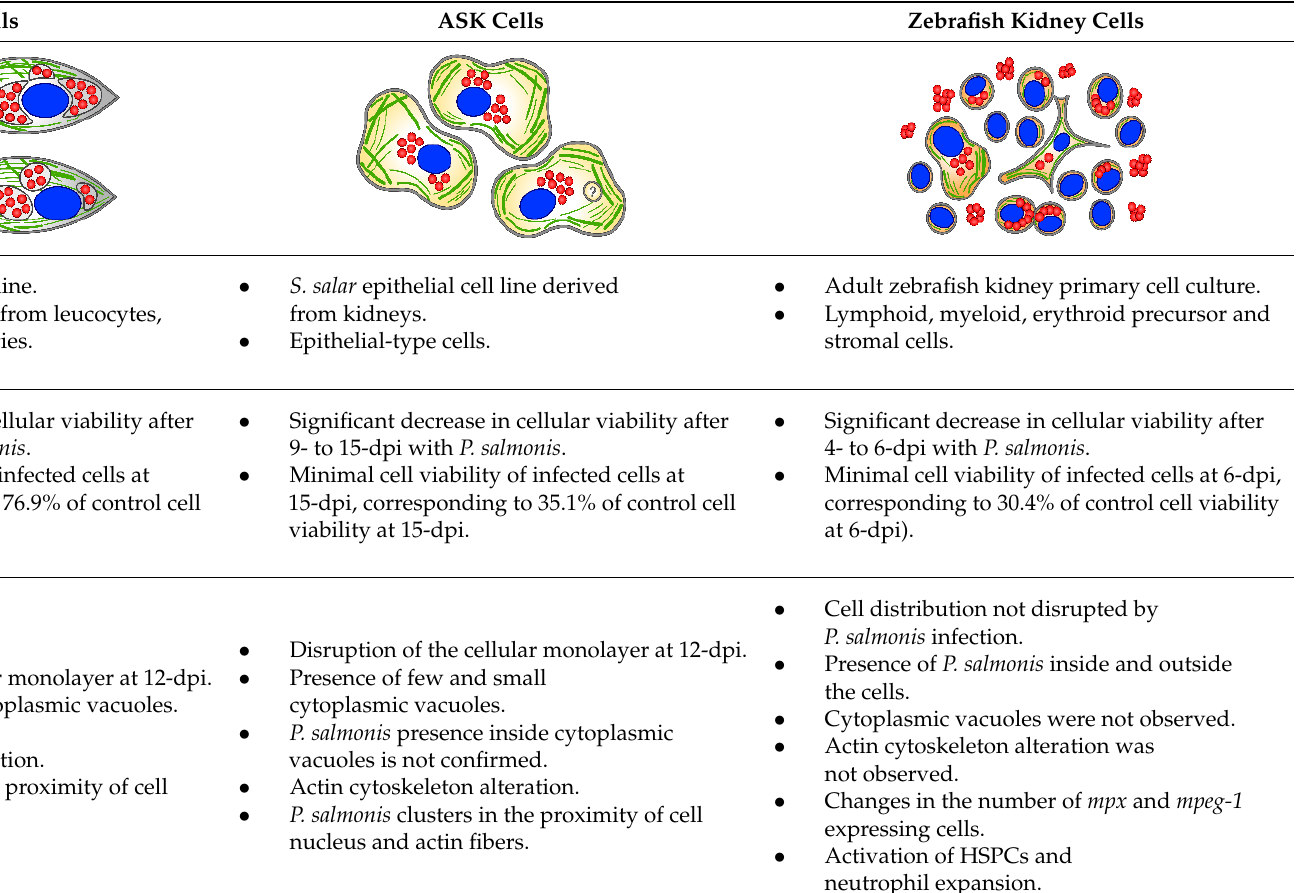
Table 1. Comparative table of P. salmonis infection effects in salmon and zebrafish cell cultures. SHK-1 Cells ASK